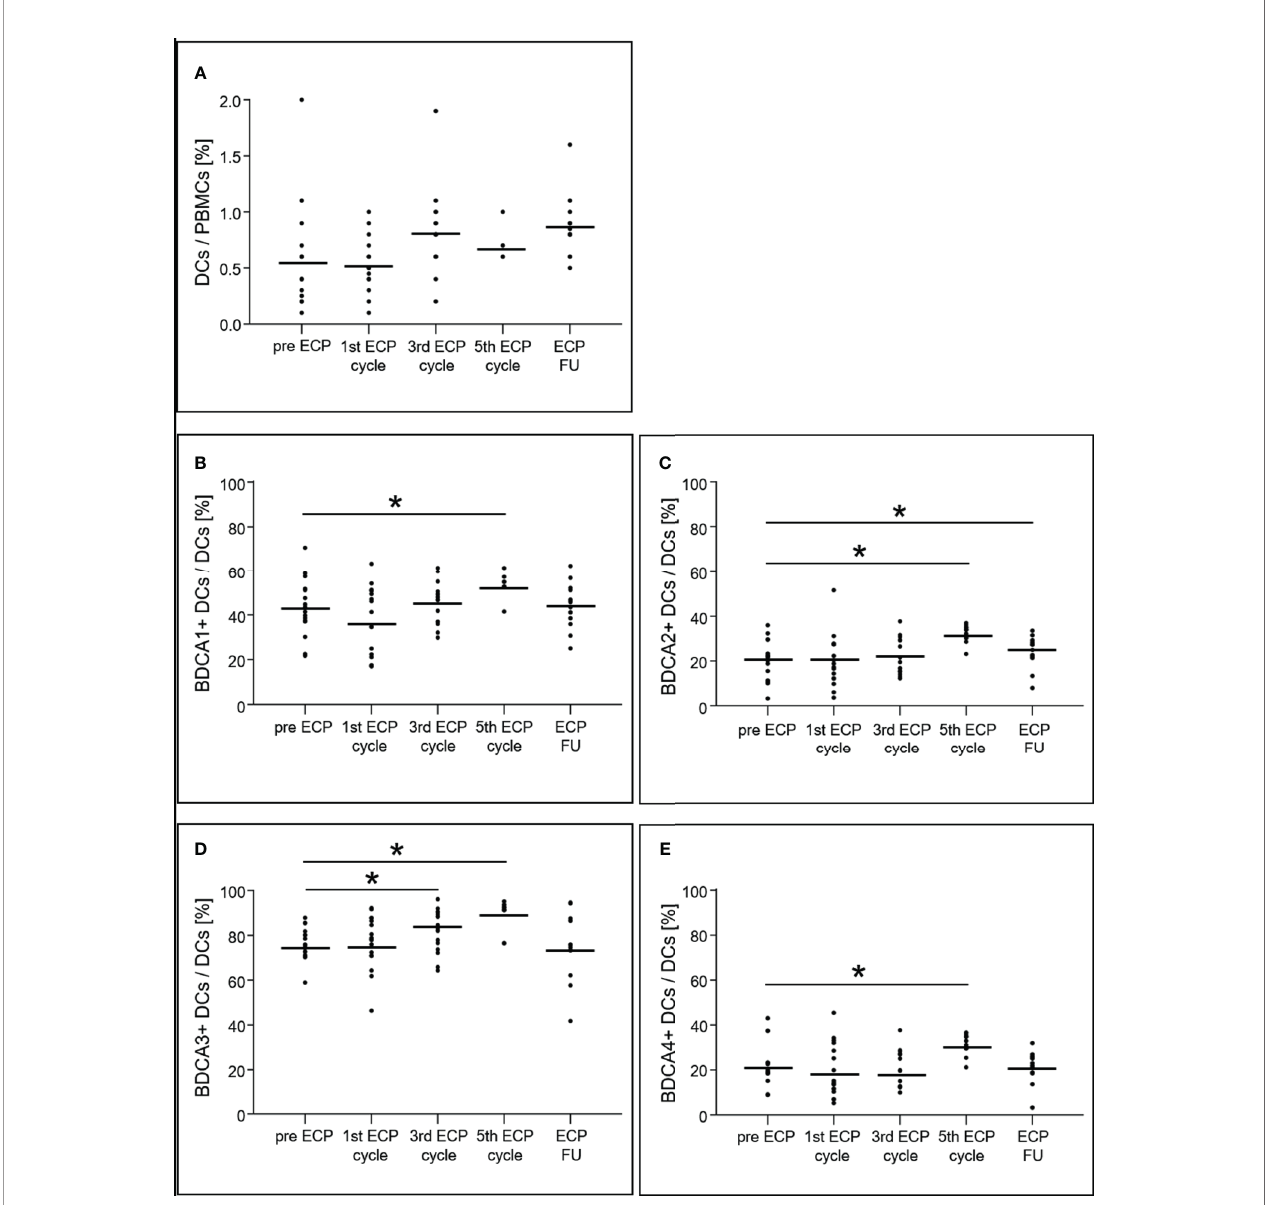
FIGURE 2 | Expression of dendritic cells (A) and their subsets (B – E) in heart-transplanted patients receiving extracorporeal photopheresis. * marks signi fi cant differences (p ≤ 0.05); BDCA1/2/3/4, blood dendritic cell antigen 1/2/3/4; DCs, dendritic cells; ECP, extracorporeal photopheresis; FU, follow-up; PBMCs, peripheral blood mononuclear